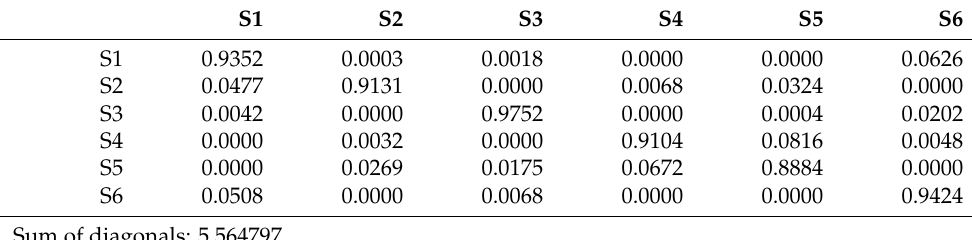
Figure 4. Clustering results of the alanine dipeptide from PCCA, PCCA+ and Gib algorithms. The axis is the same as that in Figure 3. ( A ) PCCA with 6 clusters; ( B ) PCCA+ with estimated number of cluster belonging to [3, 9]; ( C ) PCCA+ with estimated number of cluster belonging to [5, 7]; ( D ) GSA with 6 clusters; ( E ) GSA with 5 clusters; ( F ) GSA with 7 clusters. Table 2. Transition matrix between clusters of the alanine dipeptide obtained by PCCA with S1–S6 shown in Figure